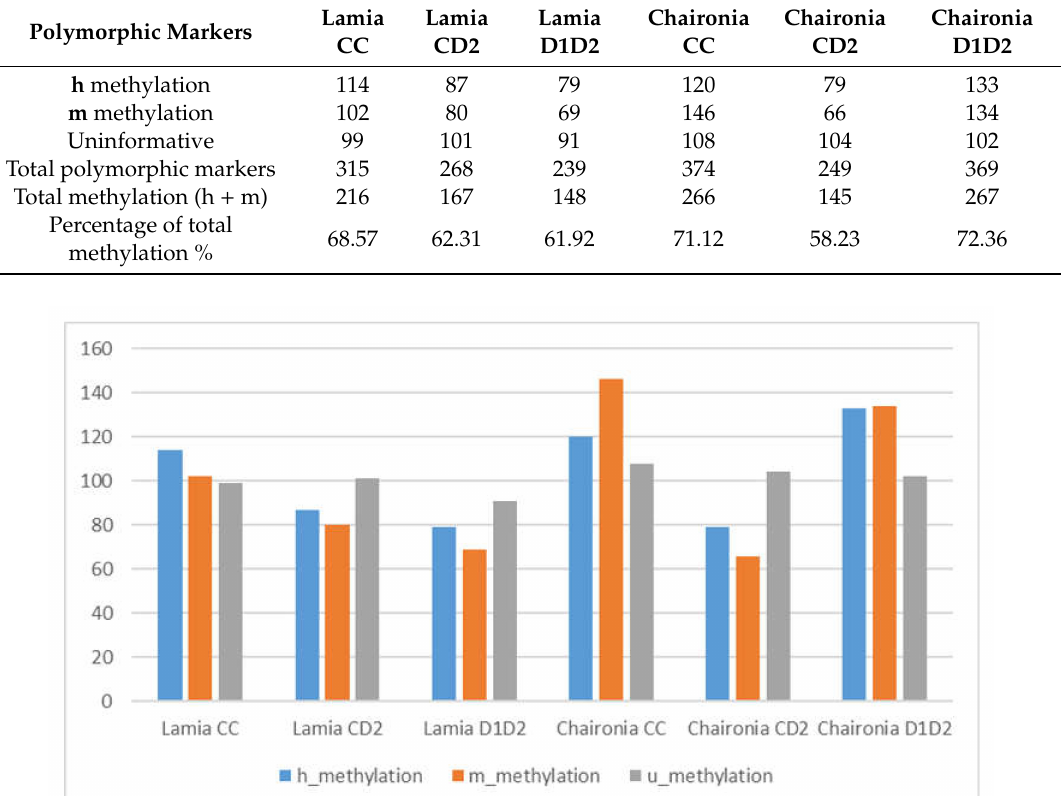
Figure 6. Methylation patterns (demonstrated as distinct h / m / u markers) of all treatments tested. Y-axis represents total methylation (h + m